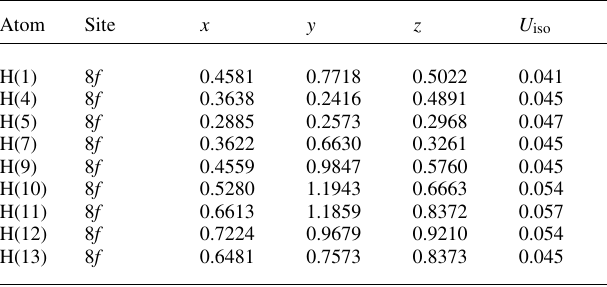
Table 2. Atomic coordinates and displacement parameters (in Å 2 )